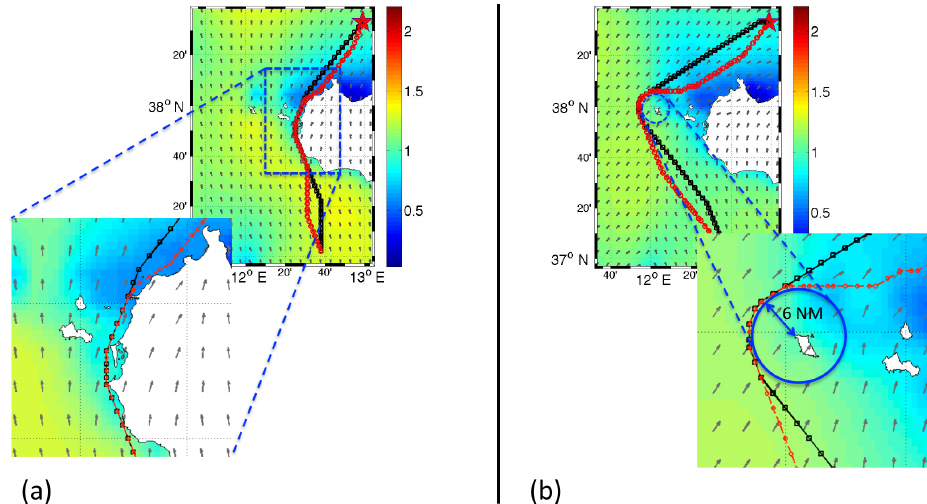
Figure 6. Routes with minimum offshore distance ρ set to zero (panel a ) or to 6M (panel b ). The inset of (a) displays that even for ρ = 0 the land mass is avoided, while the inset of (b) demonstrates that the routes are locally tangent to a circle of radius ρ = 6M centred on the island of Marettimo, off the western coast of